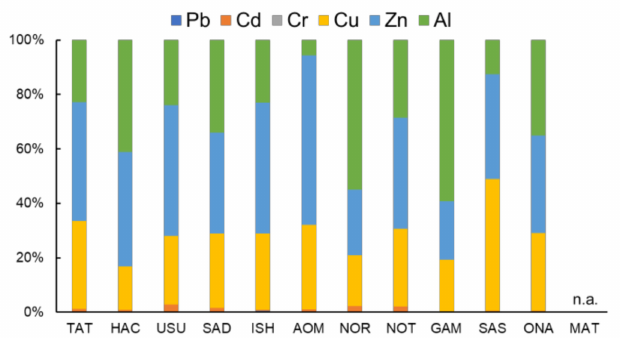
Figure 2. Proportion of each heavy metal concentration in total concentration in 11 sampling sites (n.a.: not